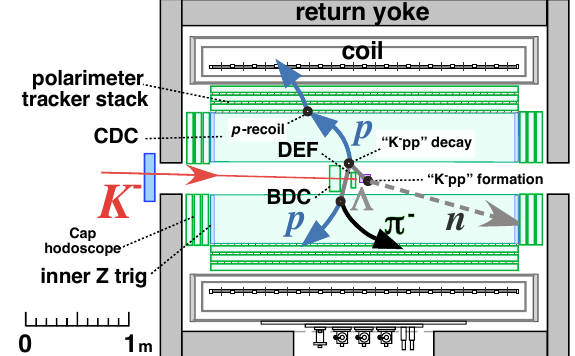
Figure 4. Conceptual design of the new cylindrical detector